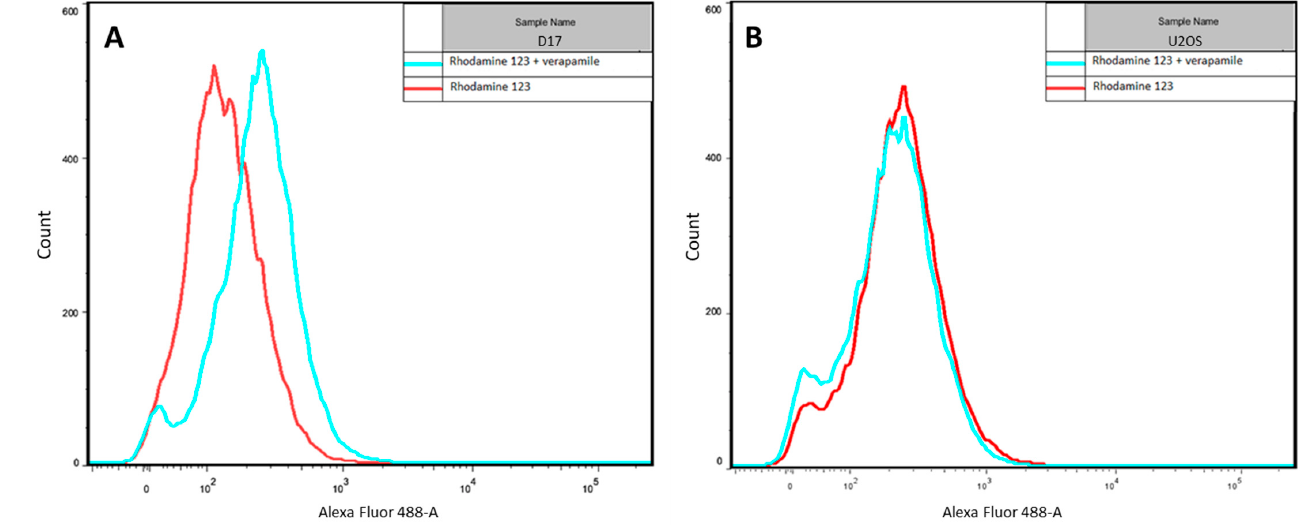
Figure 6. Fluorescence of rhodamine 123 with or without verapamil in treated D17 ( A ) and U2OS ( B ) cell lines. 2.6. P-gp Inhibition with Verapamil Increases the Intracellular Accumulation of Free Dox but Not Au-GSH-Dox in the D17 Cell Line